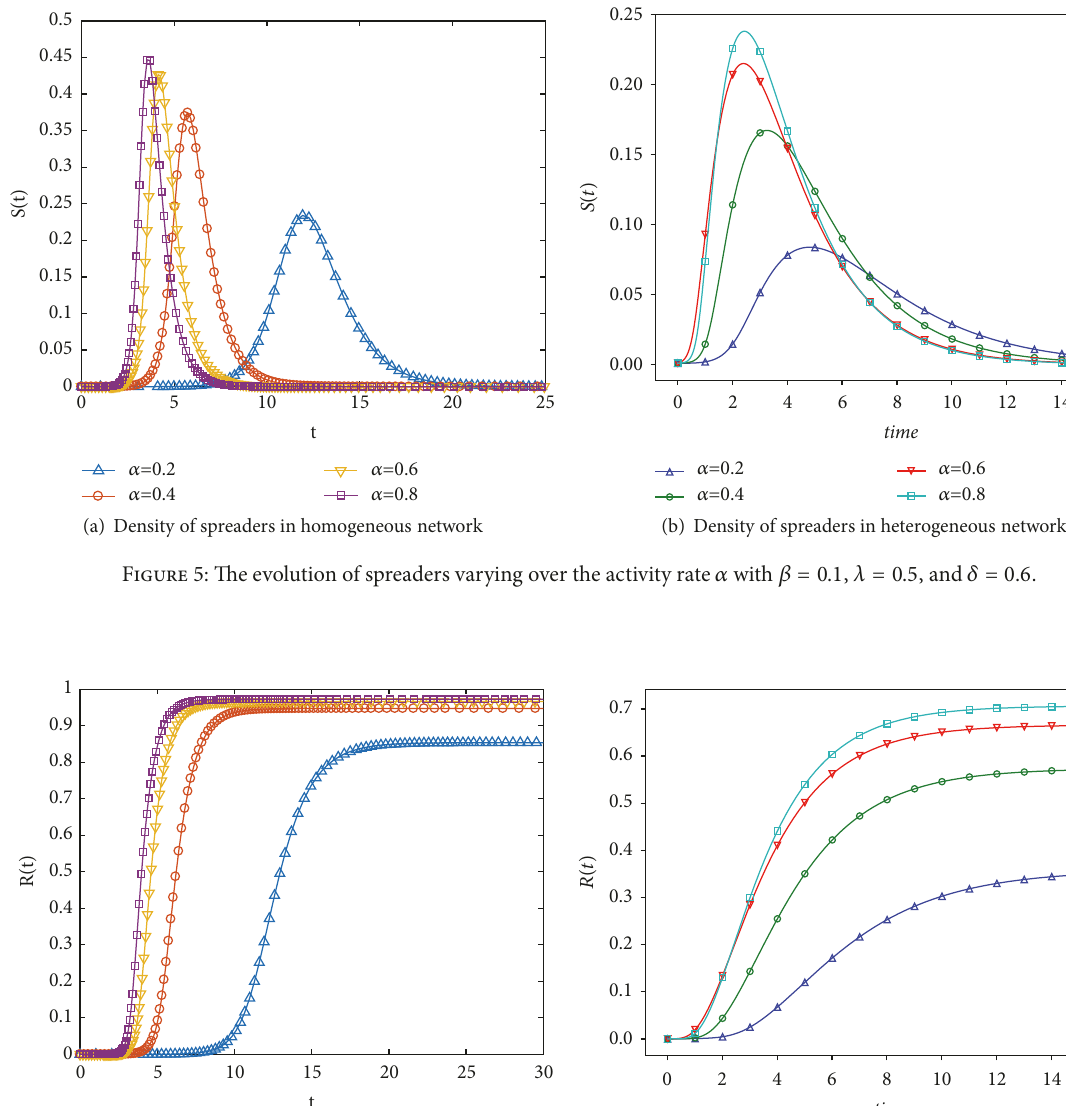
speed of rumor on heterogeneous network is much